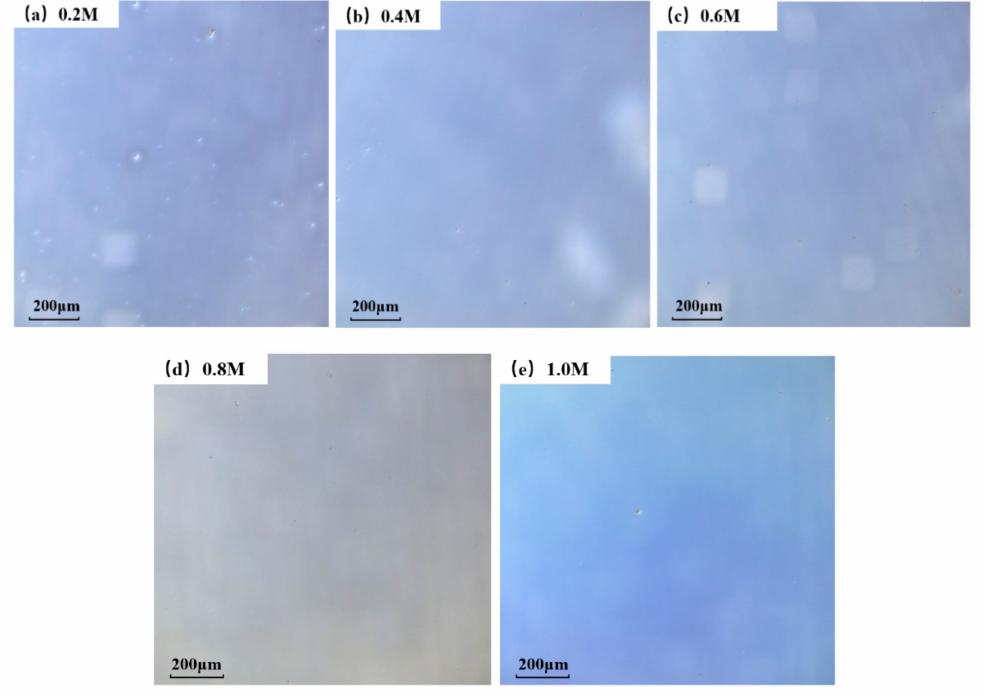
Figure 3. Optical microscopy of ZYAMO thin films annealed at 300 ◦ C at different concentrations: ( a ) 0.2 M, ( b ) 0.4 M, ( c ) 0.6 M, ( d ) 0.8 M, and ( e ) 1.0